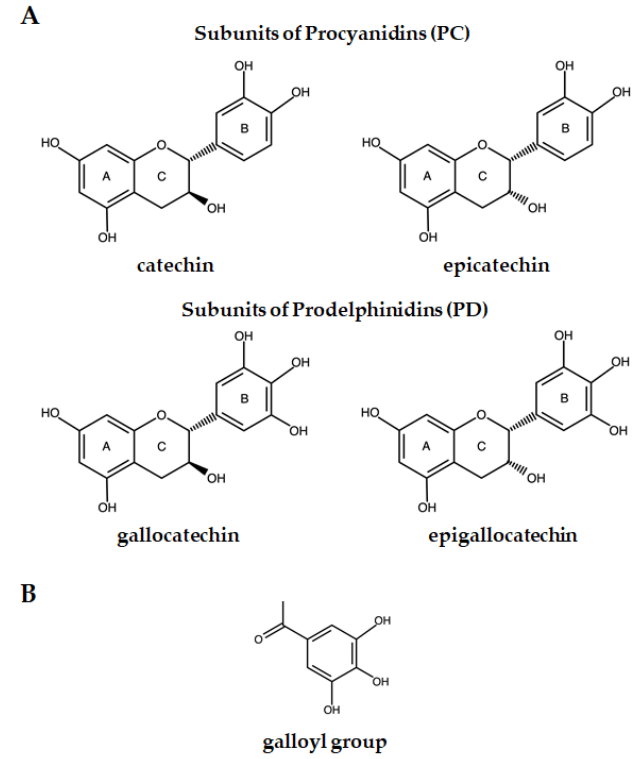
Figure 1. ( A ) Monomeric proanthocyanidins, subunits of procyanidins—catechin and epicatechin and subunits of prodelphinidin—gallocatechin and epigallocatechin; ( B ) galloyl group.